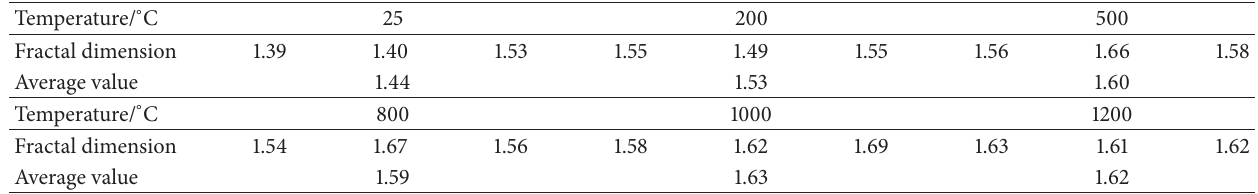
Table 1: Fractal dimensions of fracture surface after different temperature.